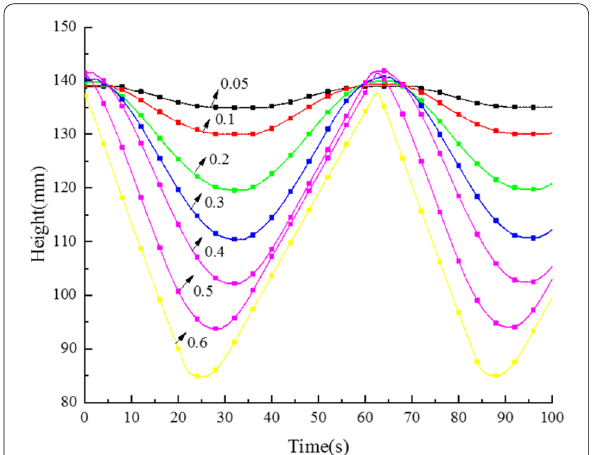
Figure 27 Changes in height at different volume ratios